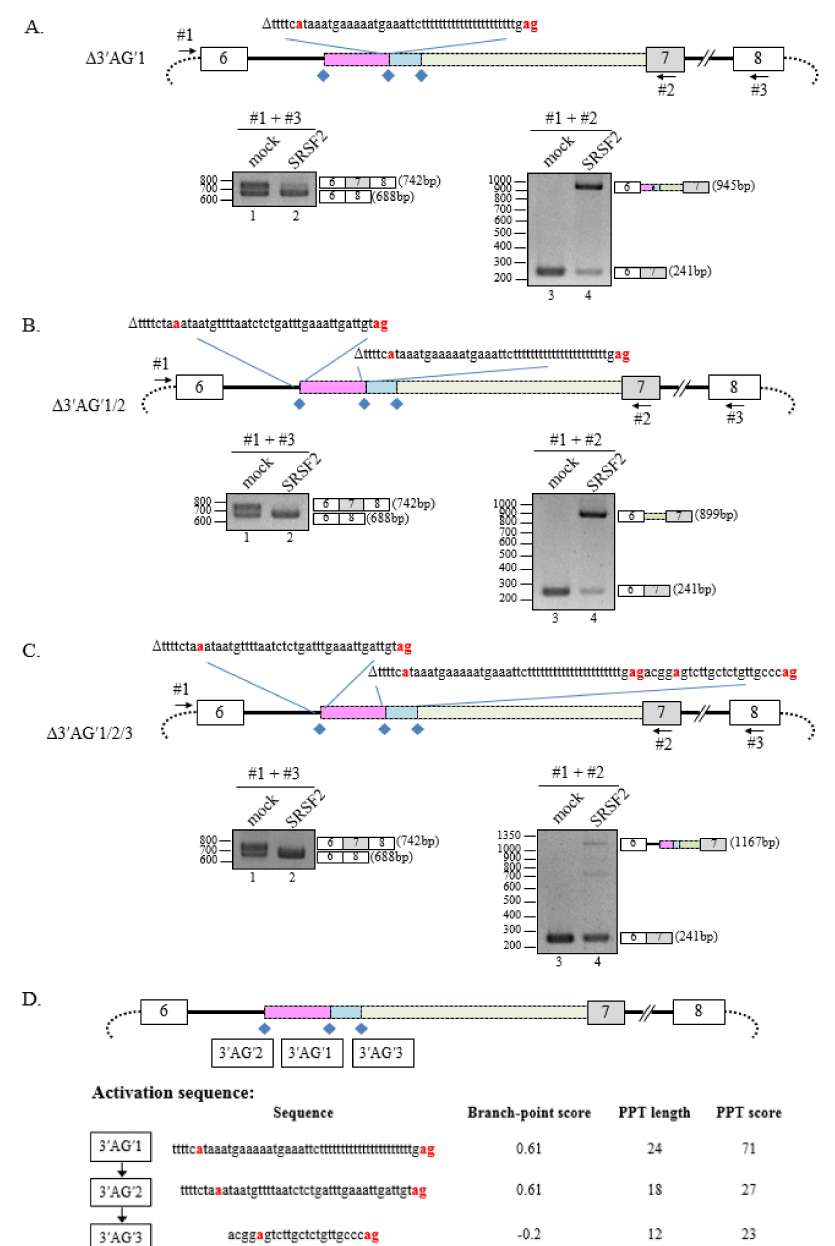
Figure 2. Deletion of 3 (cid:48) AG (cid:48) 1 region induces SRSF2-dependent usage of alternate 3 (cid:48) AG (cid:48) . ( A ) (Upper panel) Schematic diagram of the ∆ 3 (cid:48) AG (cid:48) 1 minigene. The nucleotide deletion is indicated at top but is otherwise the same as Figure 1A. (Lower panel) RT-PCR analysis of the ∆ 3 (cid:48) AG (cid:48) 1 minigene using RNA extracted from pcDNA- or SRSF2-expressing cells with primer pairs #1 and #3 (left) or #1 and #2 (right). ( B ) (Upper panel) Schematic diagram of the ∆ 3 (cid:48) AG (cid:48) 1 / 2 minigene. Both nucleotide deletions are indicated at top but is otherwise the same as Figure 1A. (Lower panel) RT-PCR analysis of the ∆ 3 (cid:48) AG (cid:48) 1 / 2 minigene using RNA extracted from pcDNA- or SRSF2-expressing cells with primer pairs #1 and #3 (left) or #1 and #2 (right). ( C ) (Upper panel) Schematic diagram of the ∆ 3 (cid:48) AG (cid:48) 1 / 2 / 3 minigene. Nucleotide deletions encompassing all three cryptic splice-sites are indicated at top but is otherwise the same as in Figure 1A. (Lower panel) RT-PCR analysis of the ∆ 3 (cid:48) AG (cid:48) 1 / 2 / 3 minigene using primers #1 and #3 (left) or #1 and #2 (right). ( D ) Summary of the order of activation (splice-site usage) of the various cryptic splice-sites based on BP score and PPT